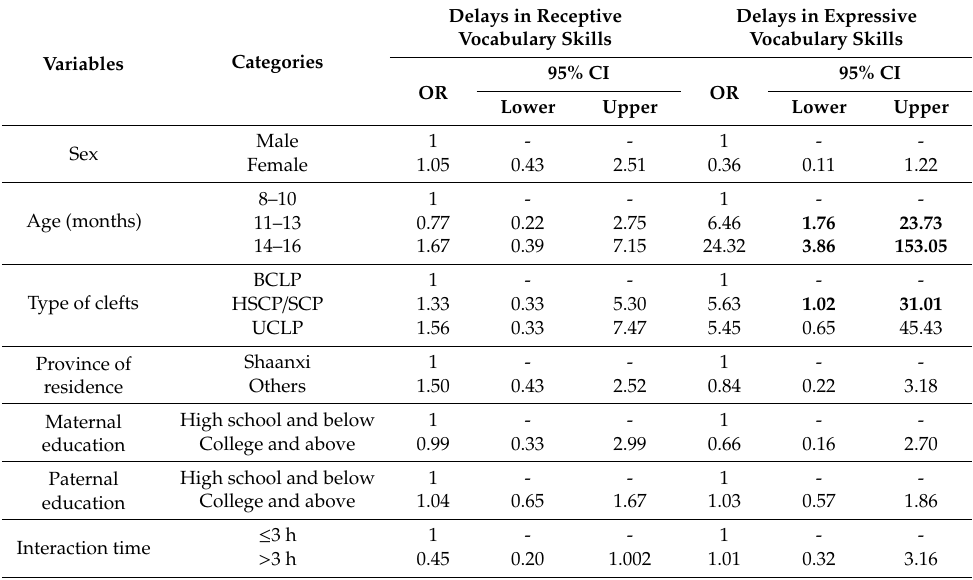
Table 2. Multiple logistic regressions on the associations between sociodemographic and clinical characteristics and vocabulary skills ( n =